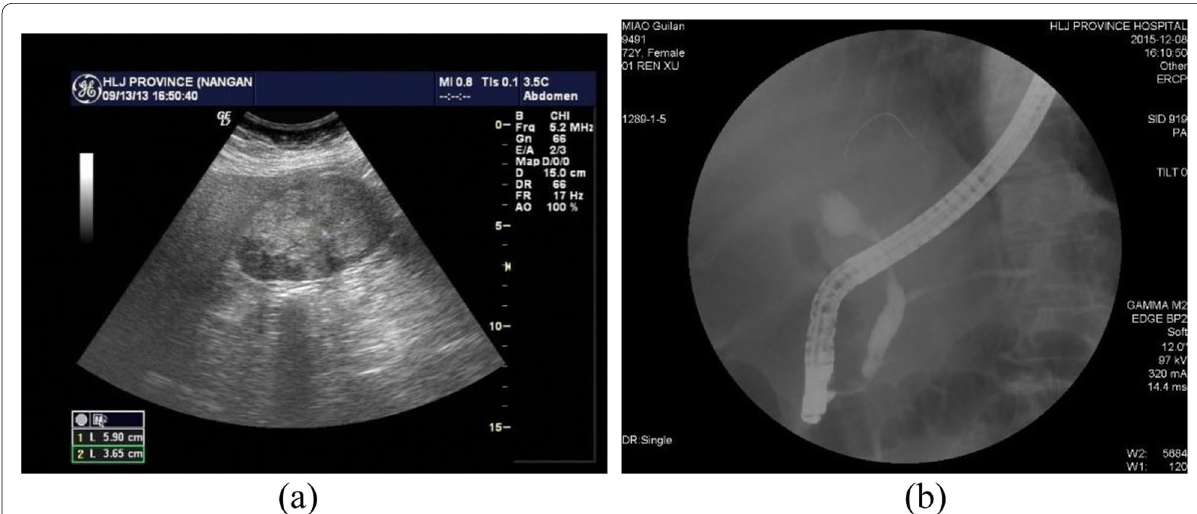
Fig. 1 Case 1: a abdominal ultrasonography. A 6-cm-diameter, irregular polypoid mass was visualized in the gallbladder lumen. b ERCP revealed common hepatic duct stricture 27 months after the procedure, and a bile duct biopsy was